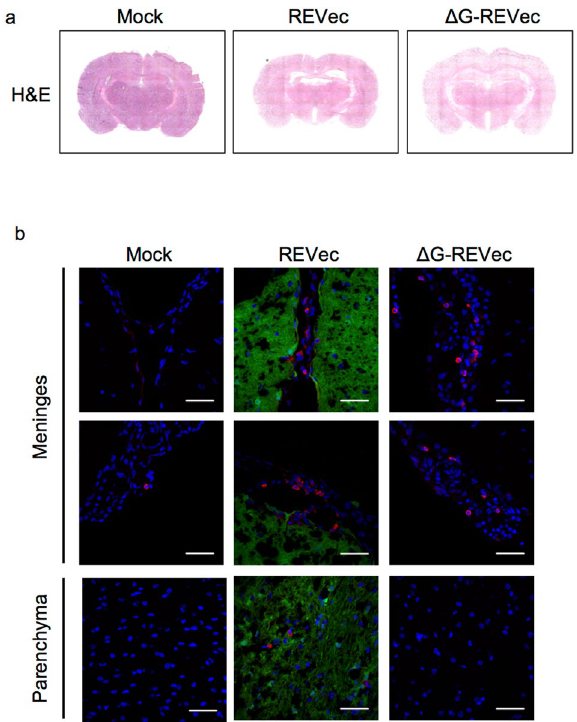
Figure 4. Histology analysis of brain at 12 weeks post-administration. ( a ) H&E staining of mock, REVec- GFP or Δ G-REVec-GFP brain sections (10 μ m). ( b ) Immunohistochemistry of coronal brain sections (20 μ m) stained with CD8 antibody (red) and counterstained with DAPI. CD8 T cells in brain parenchyma and meninges are shown. Scale bar, 50 μ m.